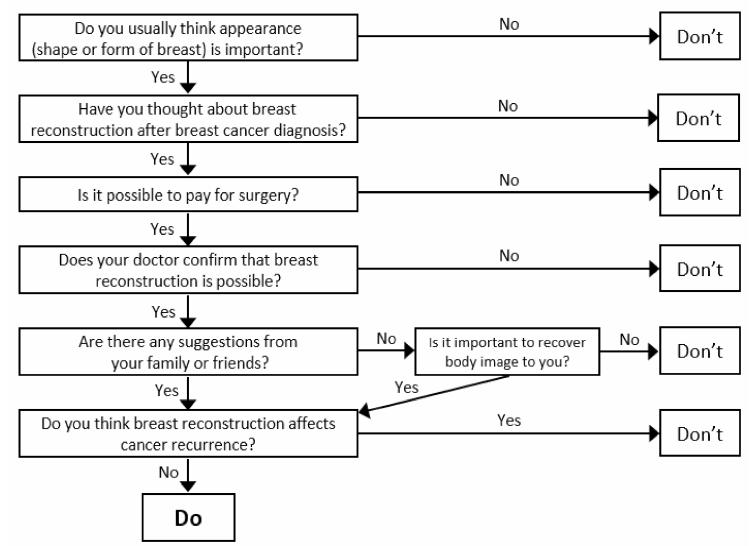
Figure 2. Modified preliminary decision tree model for breast